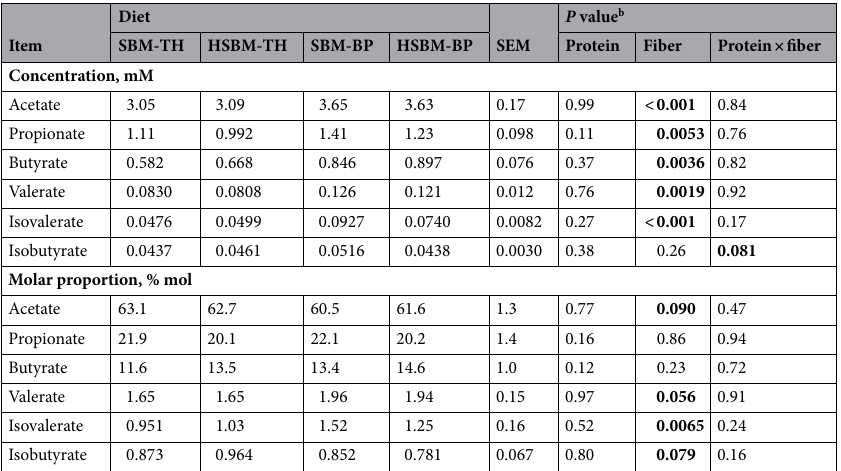
Table 3. LS means for ruminal VFA concentrations and molar proportions as differentiated by diet along with P values for the effects of protein source, fiber source, and the interaction of protein and fiber source a